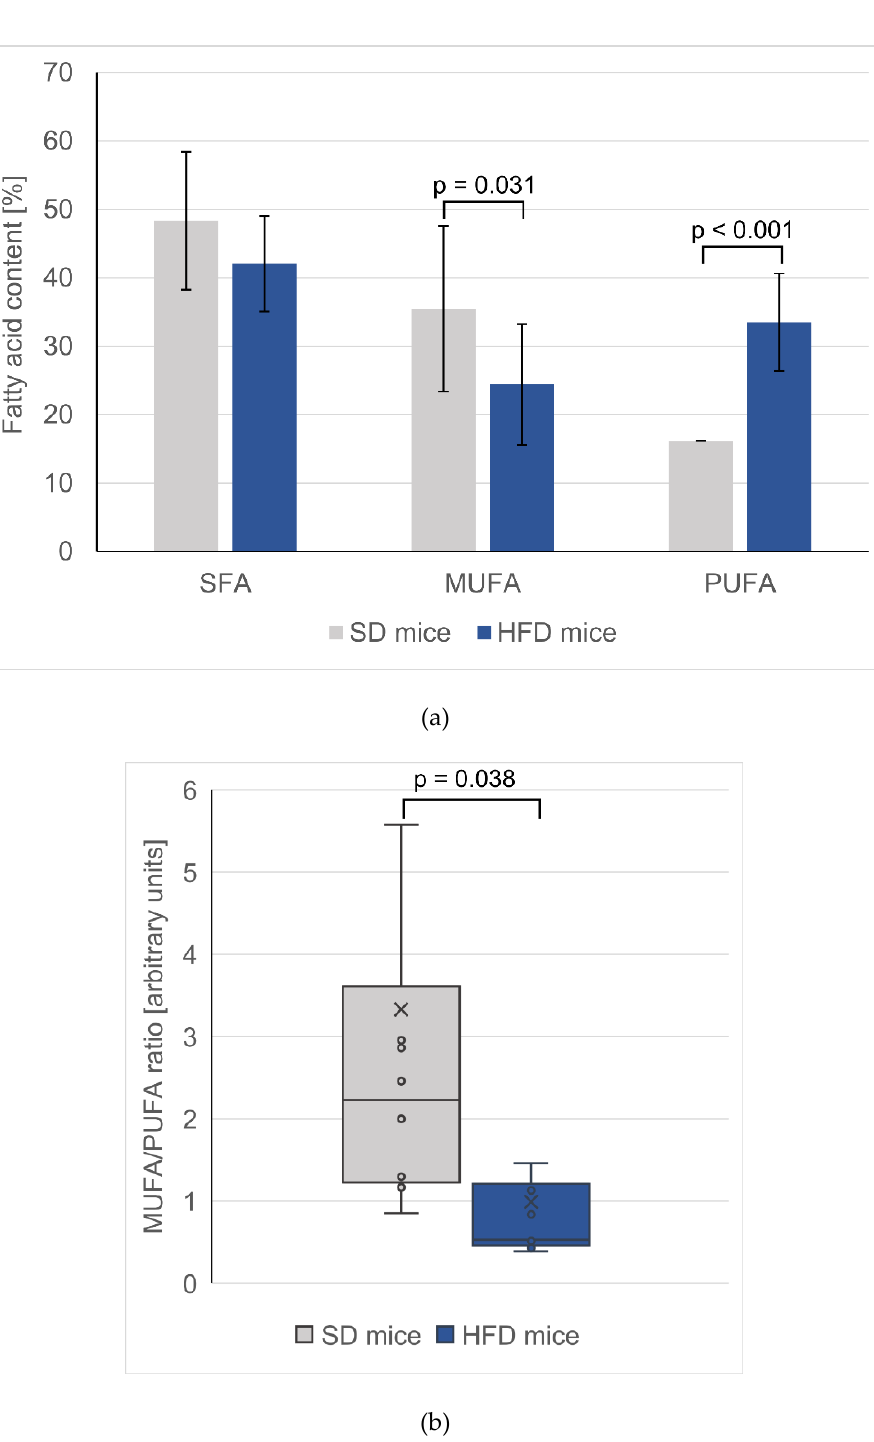
Figure 1. ( a ) Total saturated, monounsaturated and polyunsaturated fatty acids content in hearts. Values are mean ± SD. ( b ) Box-plot of monounsaturated to polyunsaturated fatty acid ratio in mice hearts. SD – mice fed standard diet; HFD – mice fed high fat diet